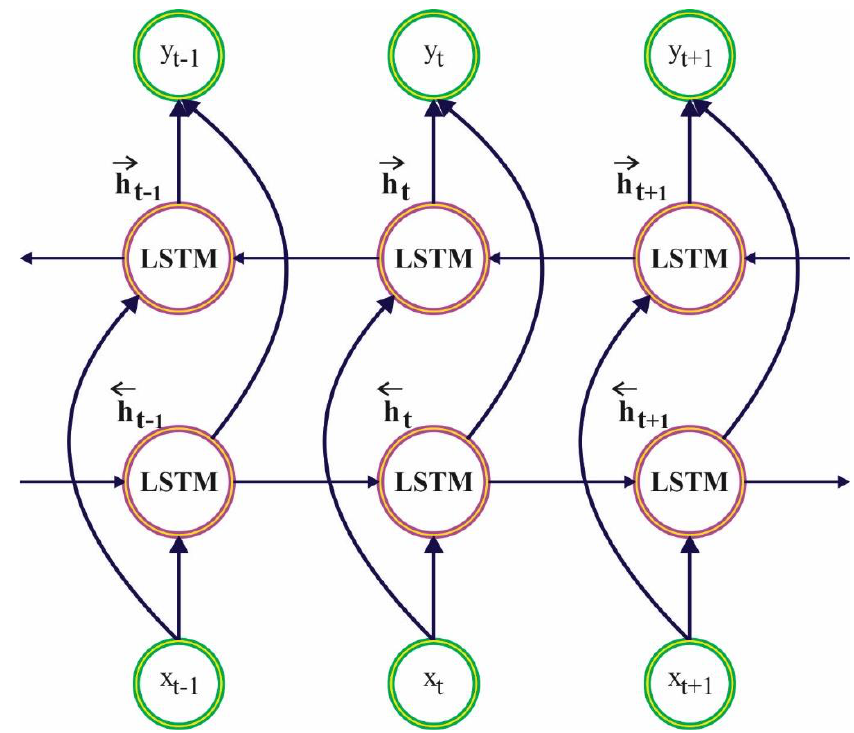
Figure 2. Architecture of Bi-LSTM.